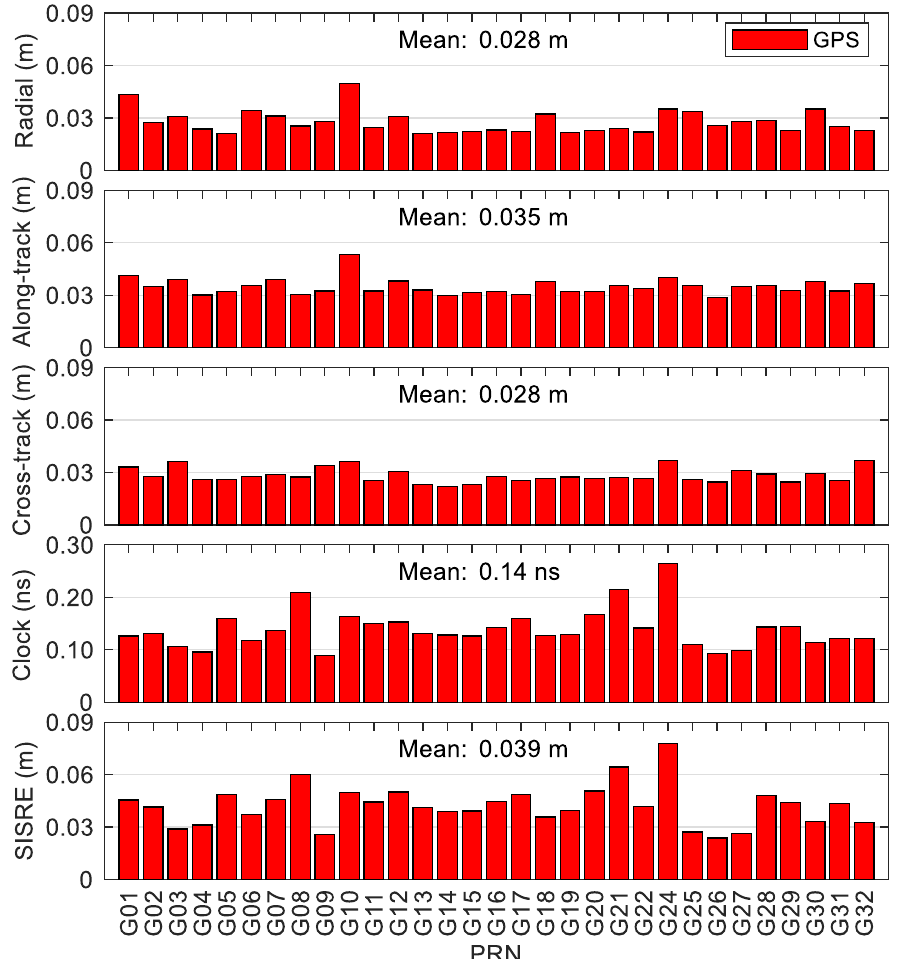
Figure 13. Statistics of errors of GPS real-time precise satellite orbits and clocks.